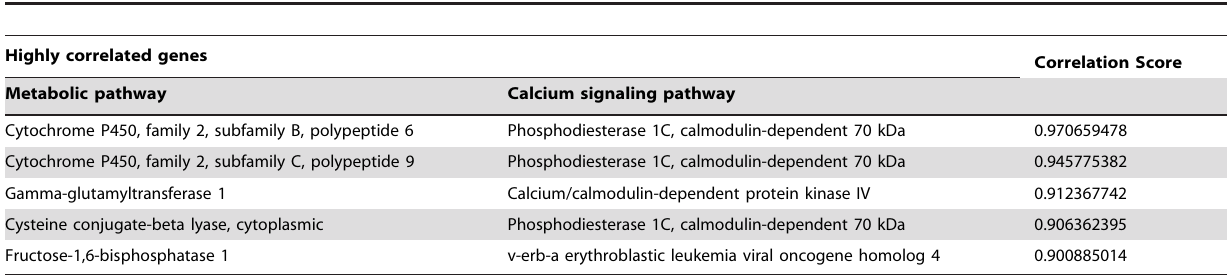
Table 7. Sample correlation scores of highly correlated genes (Metabolic and Calcium signaling pathways).